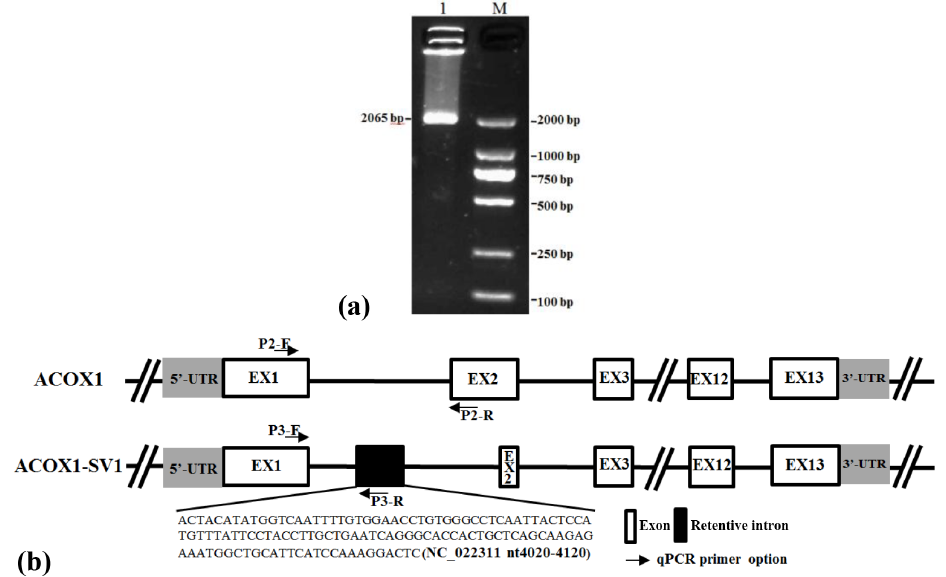
Figure 1. Detection of different isoforms (ACOX1, ACOX1-SV1) of ACOX1 in goats and schematic of genomic structure. (a) Electrophore- sis of the products obtained by RT-PCR of the mixed cDNA pool; (b) goat ACOX1 (XM_013972412) was used as the reference sequence in the diagram. Note: basic exons are shown in white boxes and alternatively spliced intron regions are shown in black box. Lines represent the basic introns. Positions of the primers P2 and P3 for RT-qPCR of the ACOX1 and the ACOX1-SV1 transcript